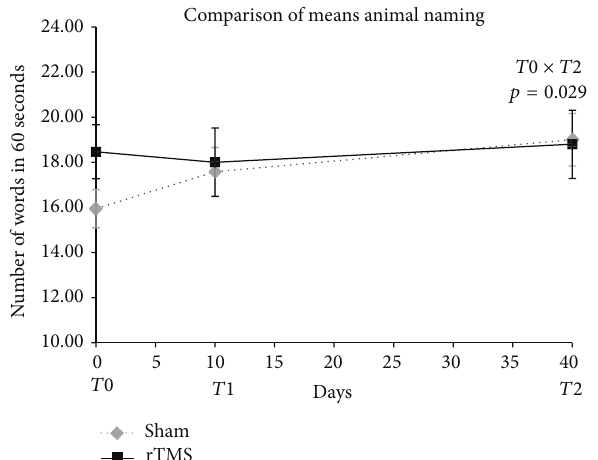
Figure 6: Comparison of semantic verbal fluency/animal naming means scores in T0, T1, and T2. Two-way ANOVA for repeated measures. Timing of procedures: T0: baseline cognitive assessment and 1st rTMS; T1: 10th rTMS session and 2nd cognitive assessment; T2: 30 days after T1 and 3rd cognitive assessment. Student’s 𝑡 -test for comparison of rTMS versus sham basal means, 𝑝 = 0.081